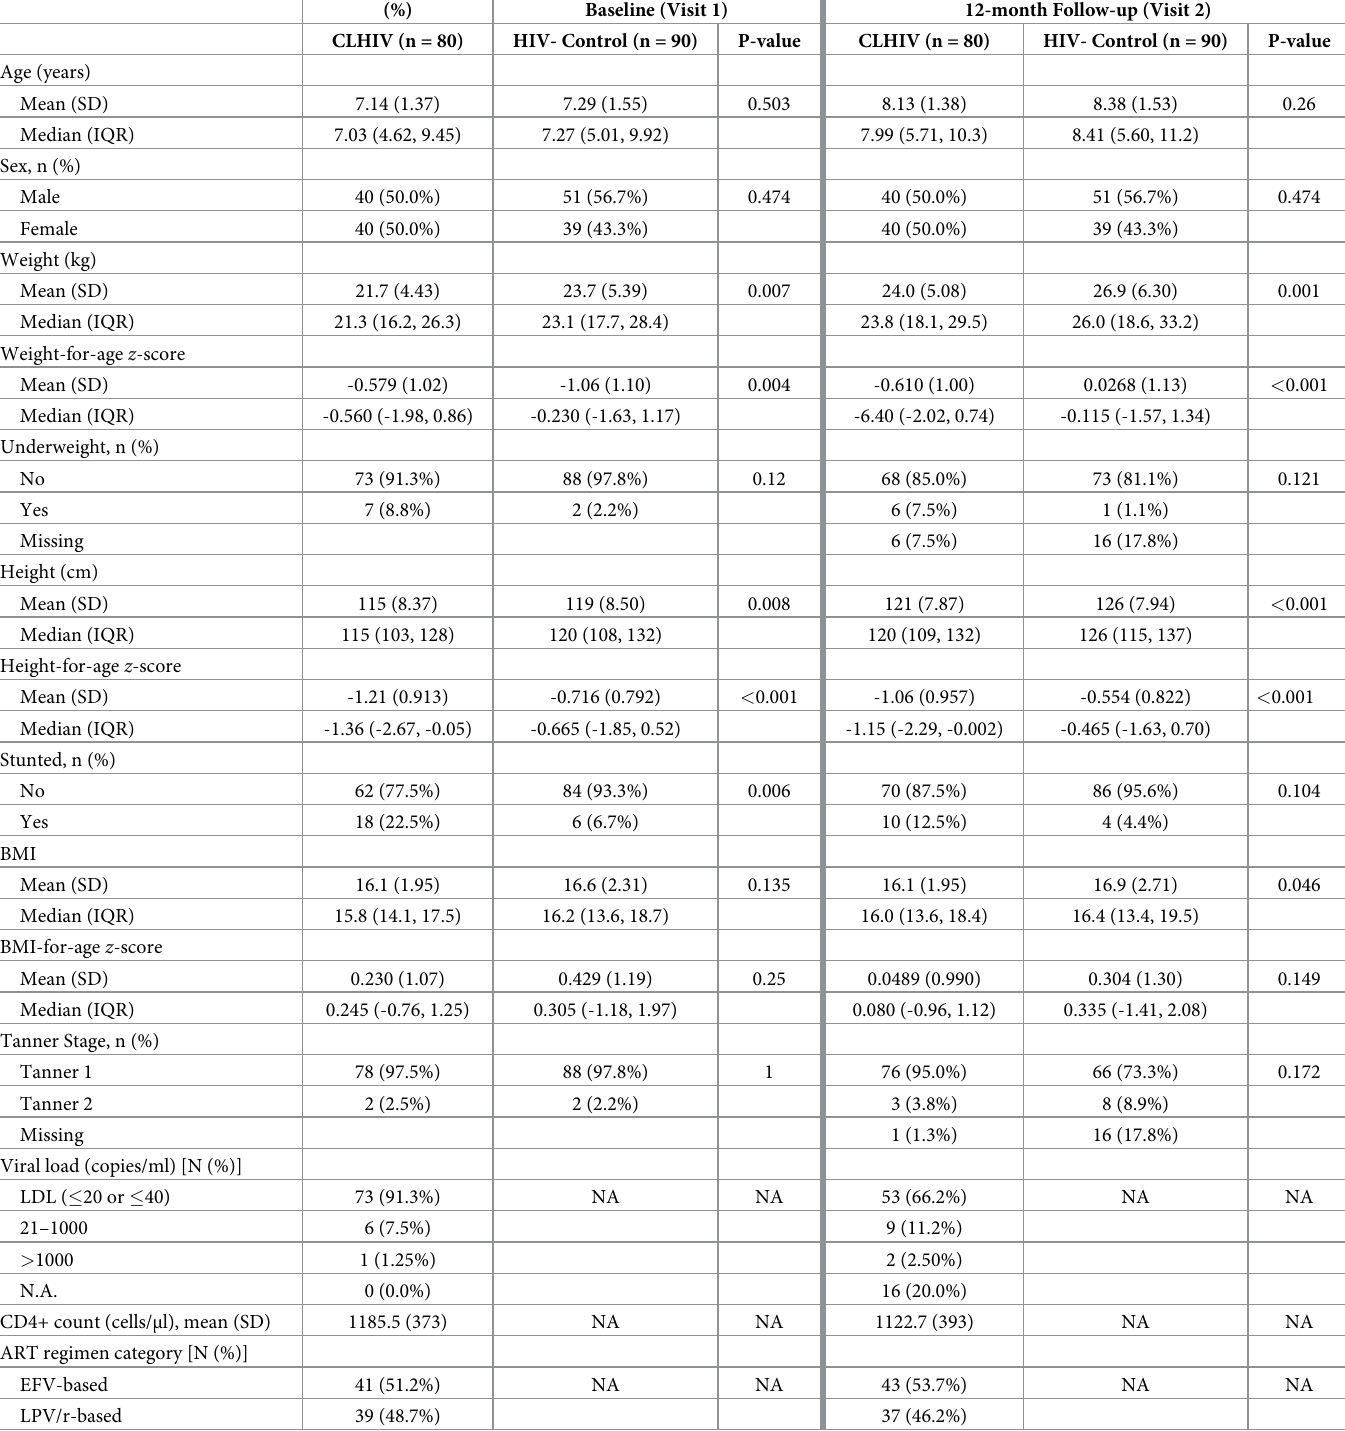
Table 1. Demographic characteristics of participants with insight calcaneal QUS